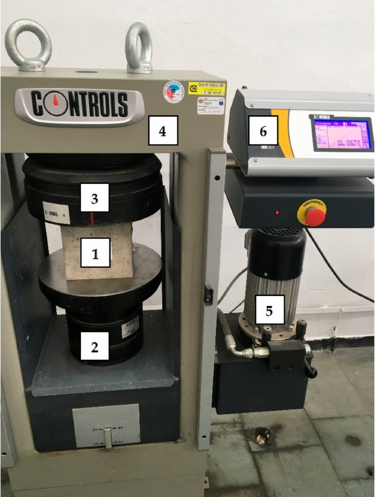
Figure 3. Set-up for compressive strength test: 1—sample; 2—fixed head; 3—movable head; 4—frame; 5—motor; 6—digital display